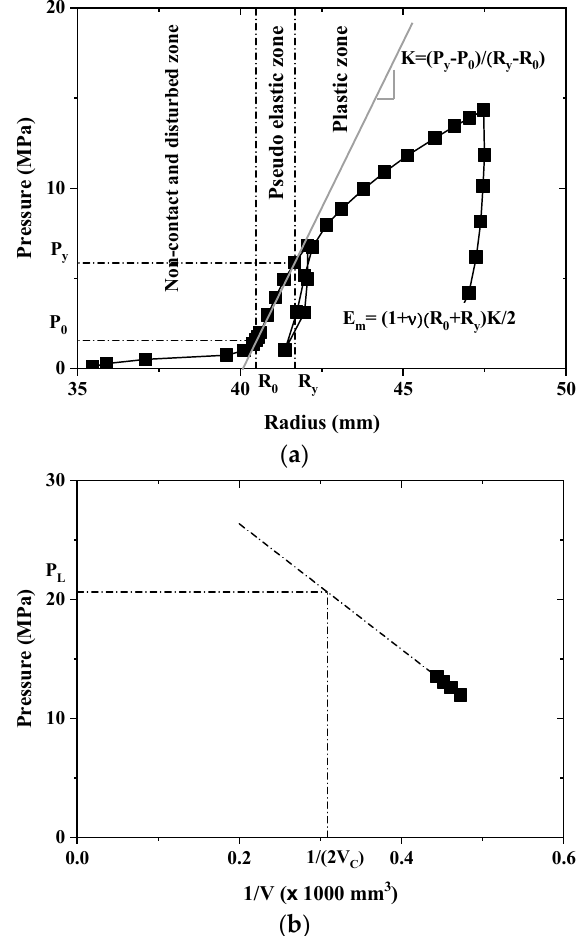
Figure 3. Interpretation of pressuremeter test (PMT) curve: ( a ) pressuremeter modulus ( E m ); ( b ) limit pressure ( P L ).